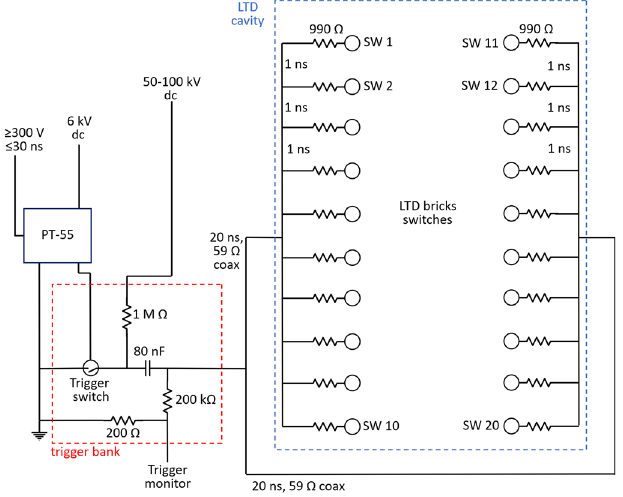
FIG. 2. Schematic of the CESZAR trigger circuit. An 80-nF capacitor bank is used to trigger the 20 switches inside the LTD cavity, with resistive coupling between the bricks. The dashed lines enclose the main units (trigger bank and LTD cavity). The 20 ns, 59 Ω cable length is present in both branches of the trigger line outside the